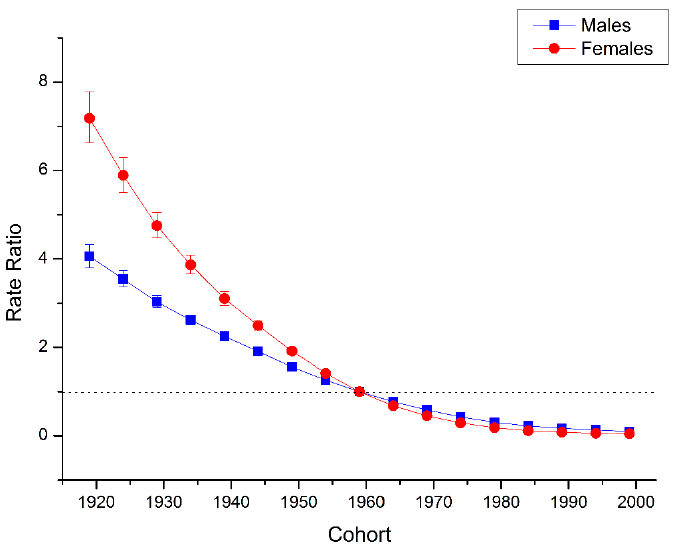
Figure 5. Cohort RRs of suicide rate by gender in China. Cohort effects obtained from age-period-cohort analyses for the suicide rates and the corresponding 95% confidence intervals (some of them were too narrow to show in the figure) by gender in China.